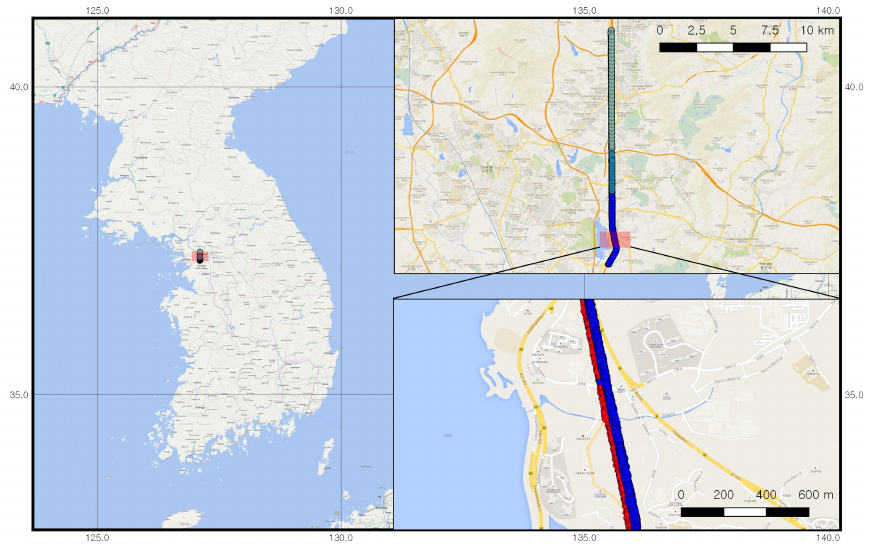
Figure 2. Experimental